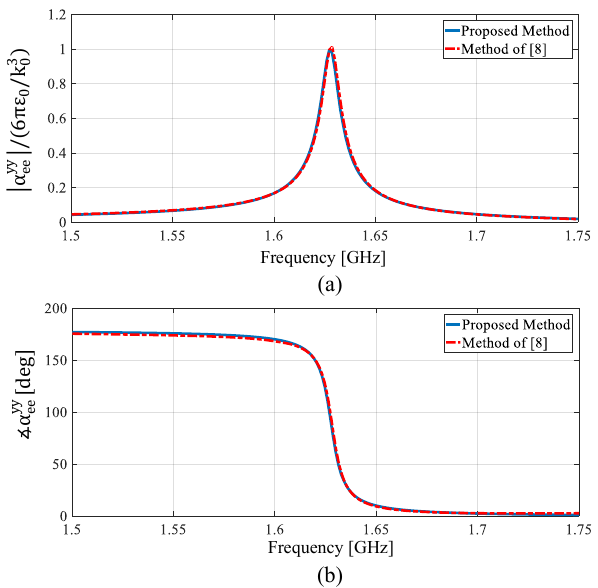
Figure 4: Magnitude and phase of normalized electric polarizability parameter of magneto-dielectric sphere. The results are compared with the free-space method explained in [8], summarized in Appendix II.